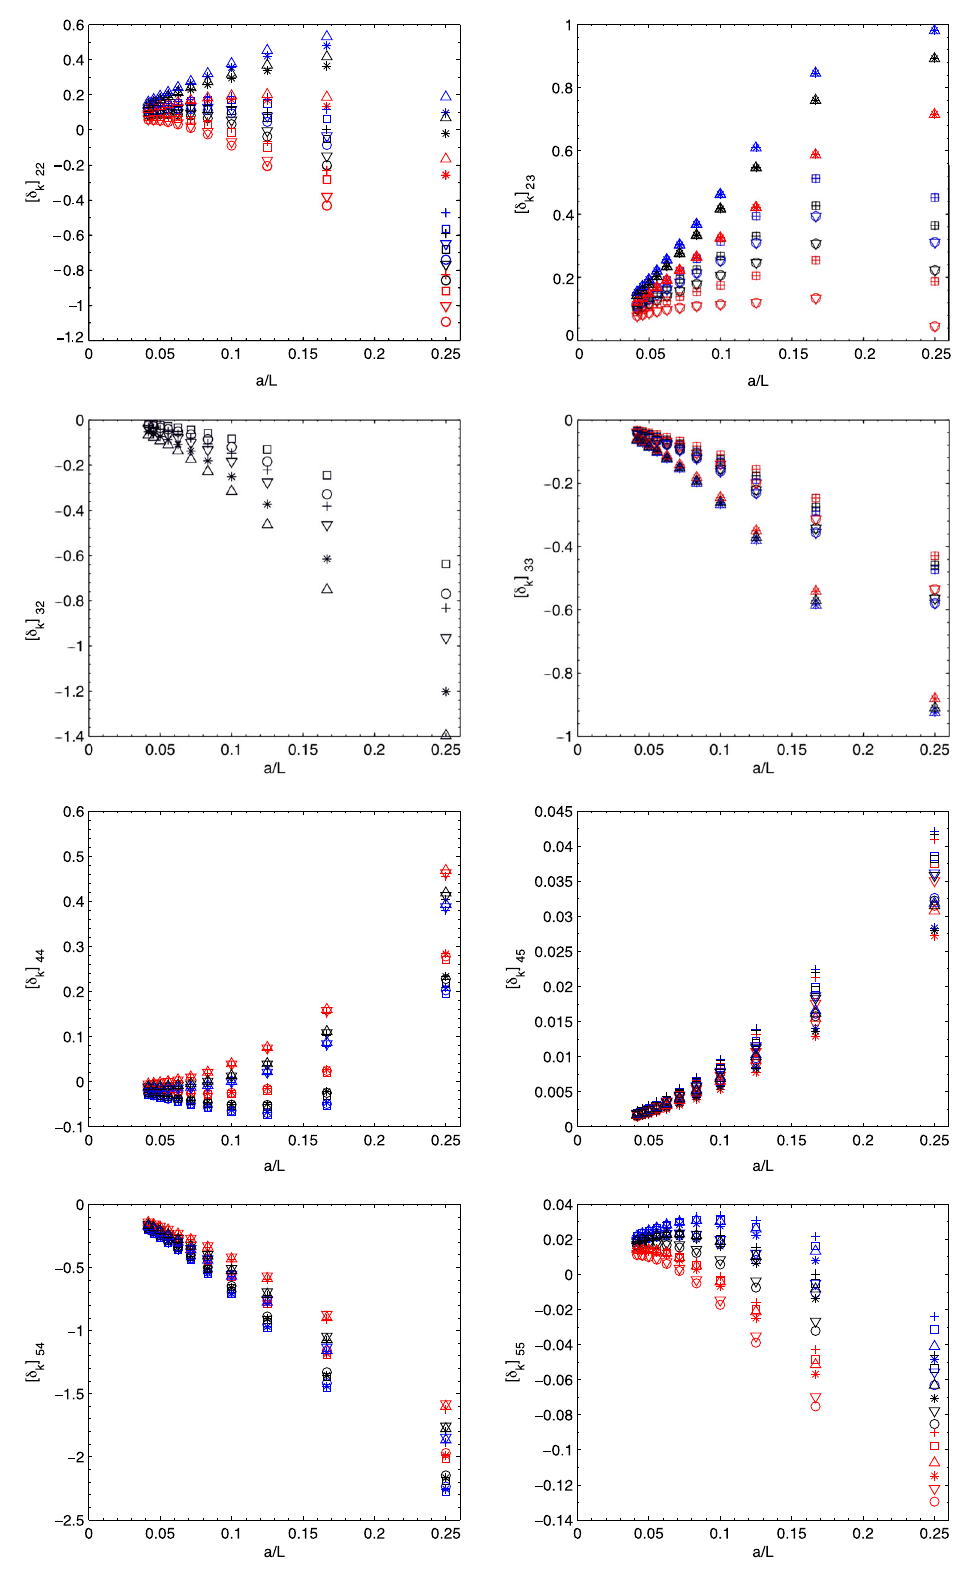
, Q + } (top) and { Q + , Q + } (bottom). Different colours distinguish 2 3 4 5